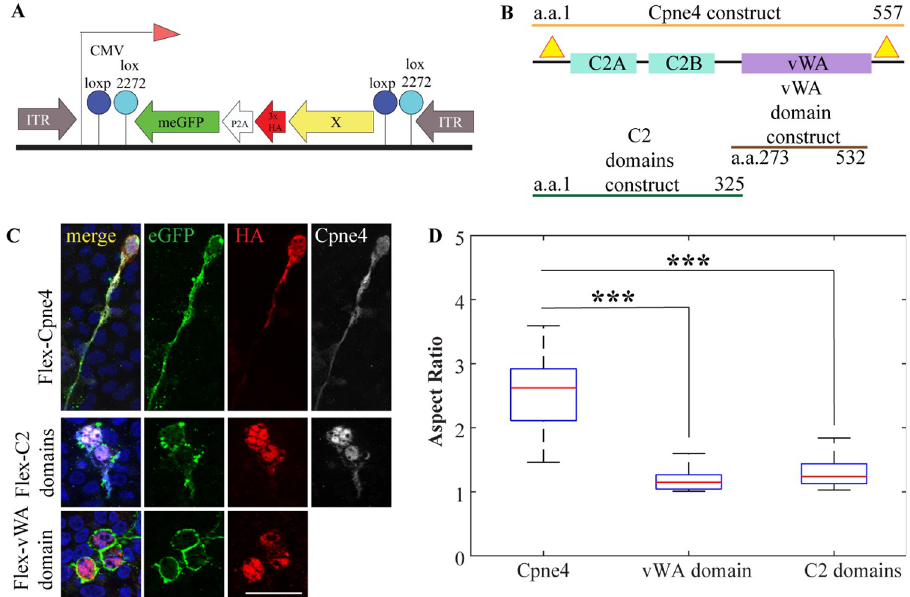
Fig 1. Cpne4 and Cpne4 dominant negative transfections in HEK293. (A) Map of the Flex construct. (B) Map of domain structure of Cpne4 shows three domains of the Cpne4 protein- two C2 domains ( blue ) and a vWA domain ( purple ). The location of the three Cpne4 plasmid constructs are shown for full length Cpne4 construct ( orange ), vWA domain construct ( brown ) and C2 domains construct ( green ). The binding of the two Cpne4 antibodies- N-terminal and C-terminal antibodies on the Cpne4 protein are indicated by yellow triangles. (C) Representative images of HEK293 cells transfected with expression constructs for full length Cpne4 (top row), C2 domains construct (middle row) and vWA domain construct (bottom row). The cells were counterstained for eGFP ( green ), HA ( red ) and N- terminal or C-terminal Cpne4 ( white ) antibodies and nuclear marker DAPI ( blue ). (D) Morphometric analysis showing aspect ratios of an ellipse fitted to the cells calculated for Cpne4, vWA domain and C2 domains transfected cells. The boxes show interquartile intervals with the median indicated with a red line and the whiskers represent the range of the observations. The mean and median aspect ratios for each group and p-values of comparisons of vWA domain and C2 domains transfected cells to Cpne4 transfected cells are given in Table 2. ��� , p < 0.001. Scale bar: 50 μ